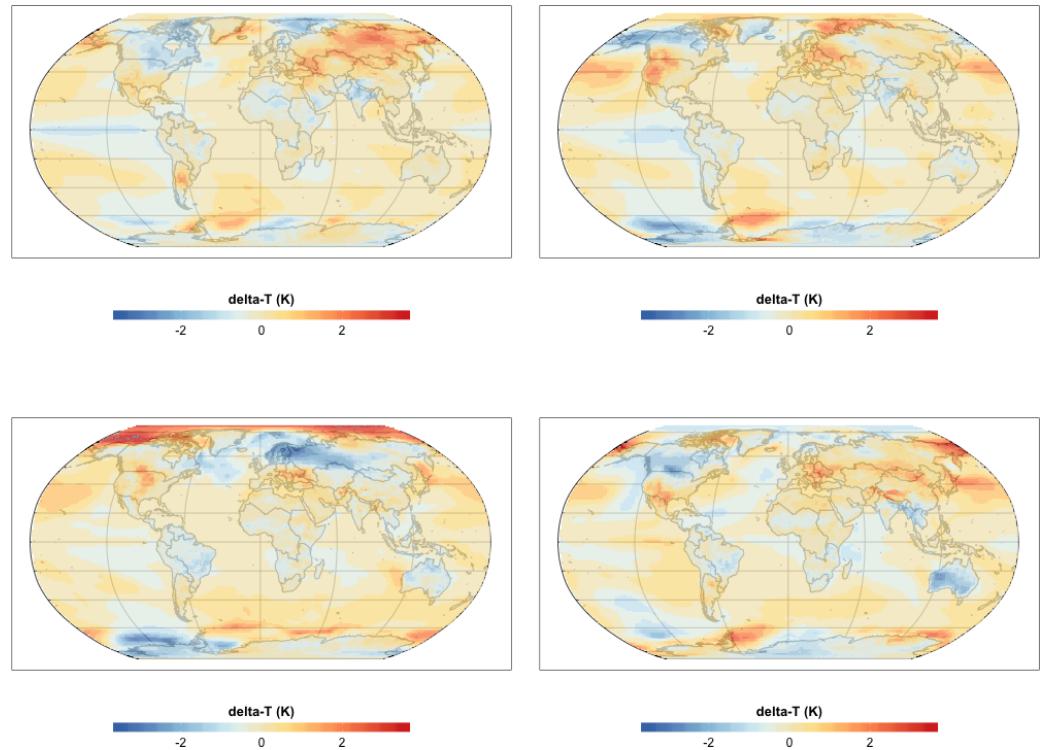
Figure 2. Year 2025 snapshot for variability fields generated using the procedure described in Sect. 2.4. Each field is a different randomly generated realization of the temperature field’s departure from the mean response (Sect. 2.3). The sequences these frames were drawn from could be used as an ensemble of future climate scenarios for studying sensitivities or uncertainties in models that use climate data as